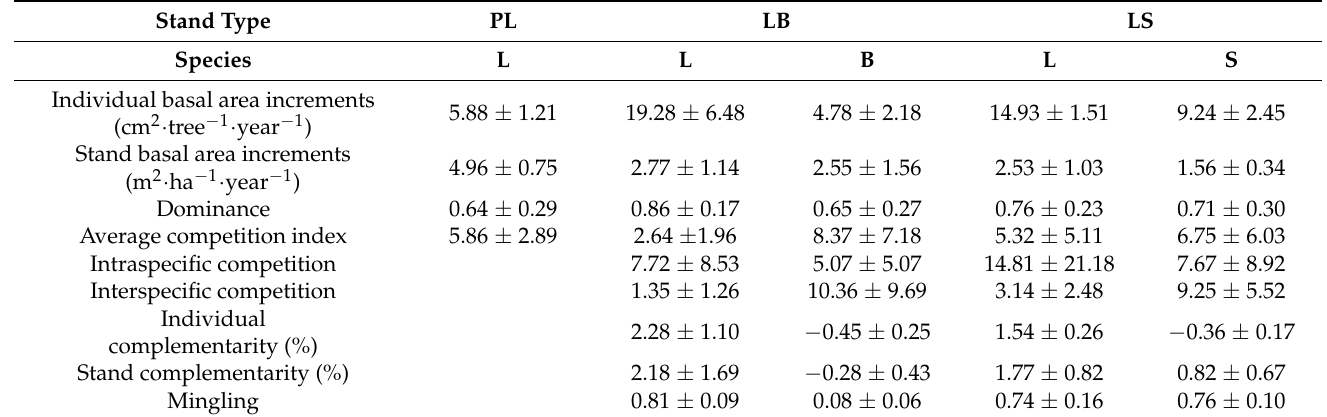
Table 2. Productivity, complementarity, and competition indices of tree species in different stand